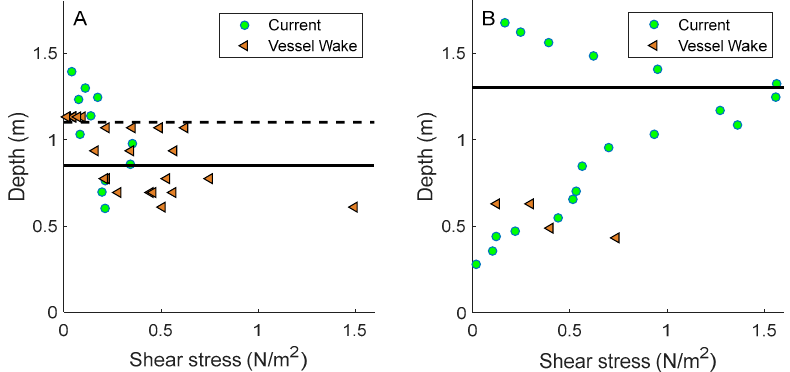
Figure 7. Stress-stage diagrams depicting the burst-averaged shear stress for the current and the maximum shear stress for the vessel wake as a function of water depth at ( A ) Station 1 and ( B ) Station 2. The solid (dashed) line denotes the toe (top) of the scarp. The marsh platform at Station 2 is at 1.8 m and is not